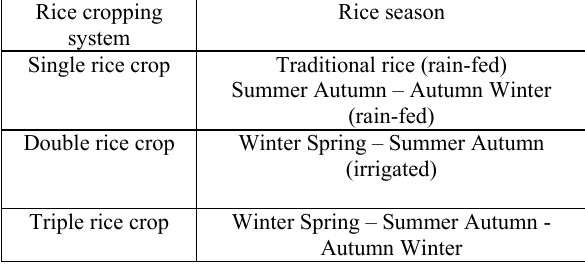
Table-1: Main Rice-based Cropping